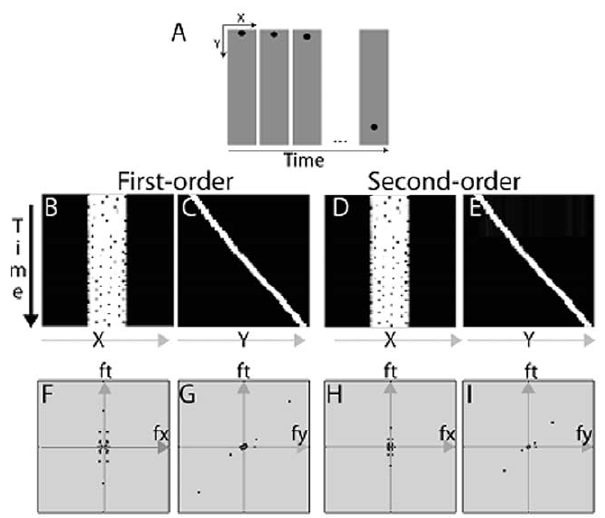
Figure 1. Motion energy analysis for a solid dropping disk. A) A series of frames depicting a solid dropping disk. B&C) First-order motion plots in the x-t and y-t planes. D&E) Projections of DC-removed and rectified second-order dropping disk movie in the x-t and y-t planes. F– I) Fourier analysis of the first-order and second-order motion energy of the solid dropping disk in the fx-ft and fy-ft